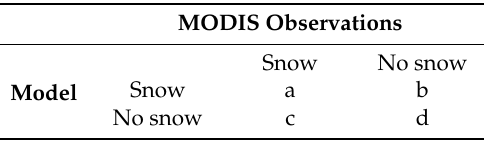
Table 1. Contingency table of observations versus model showing the count of snow/no snow event pairs.